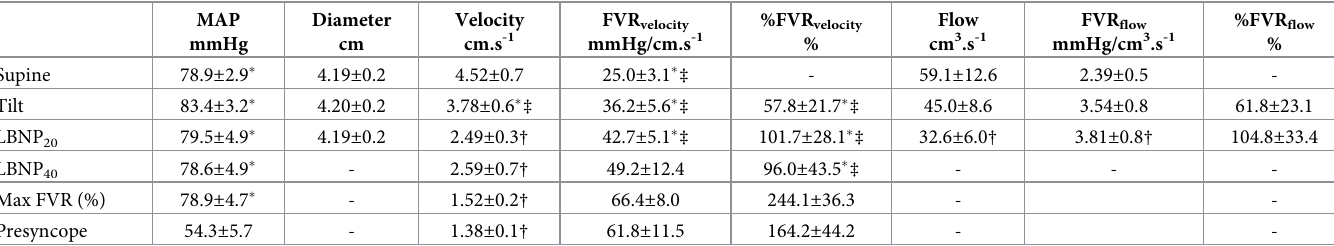
Table 1. Forearm vascular